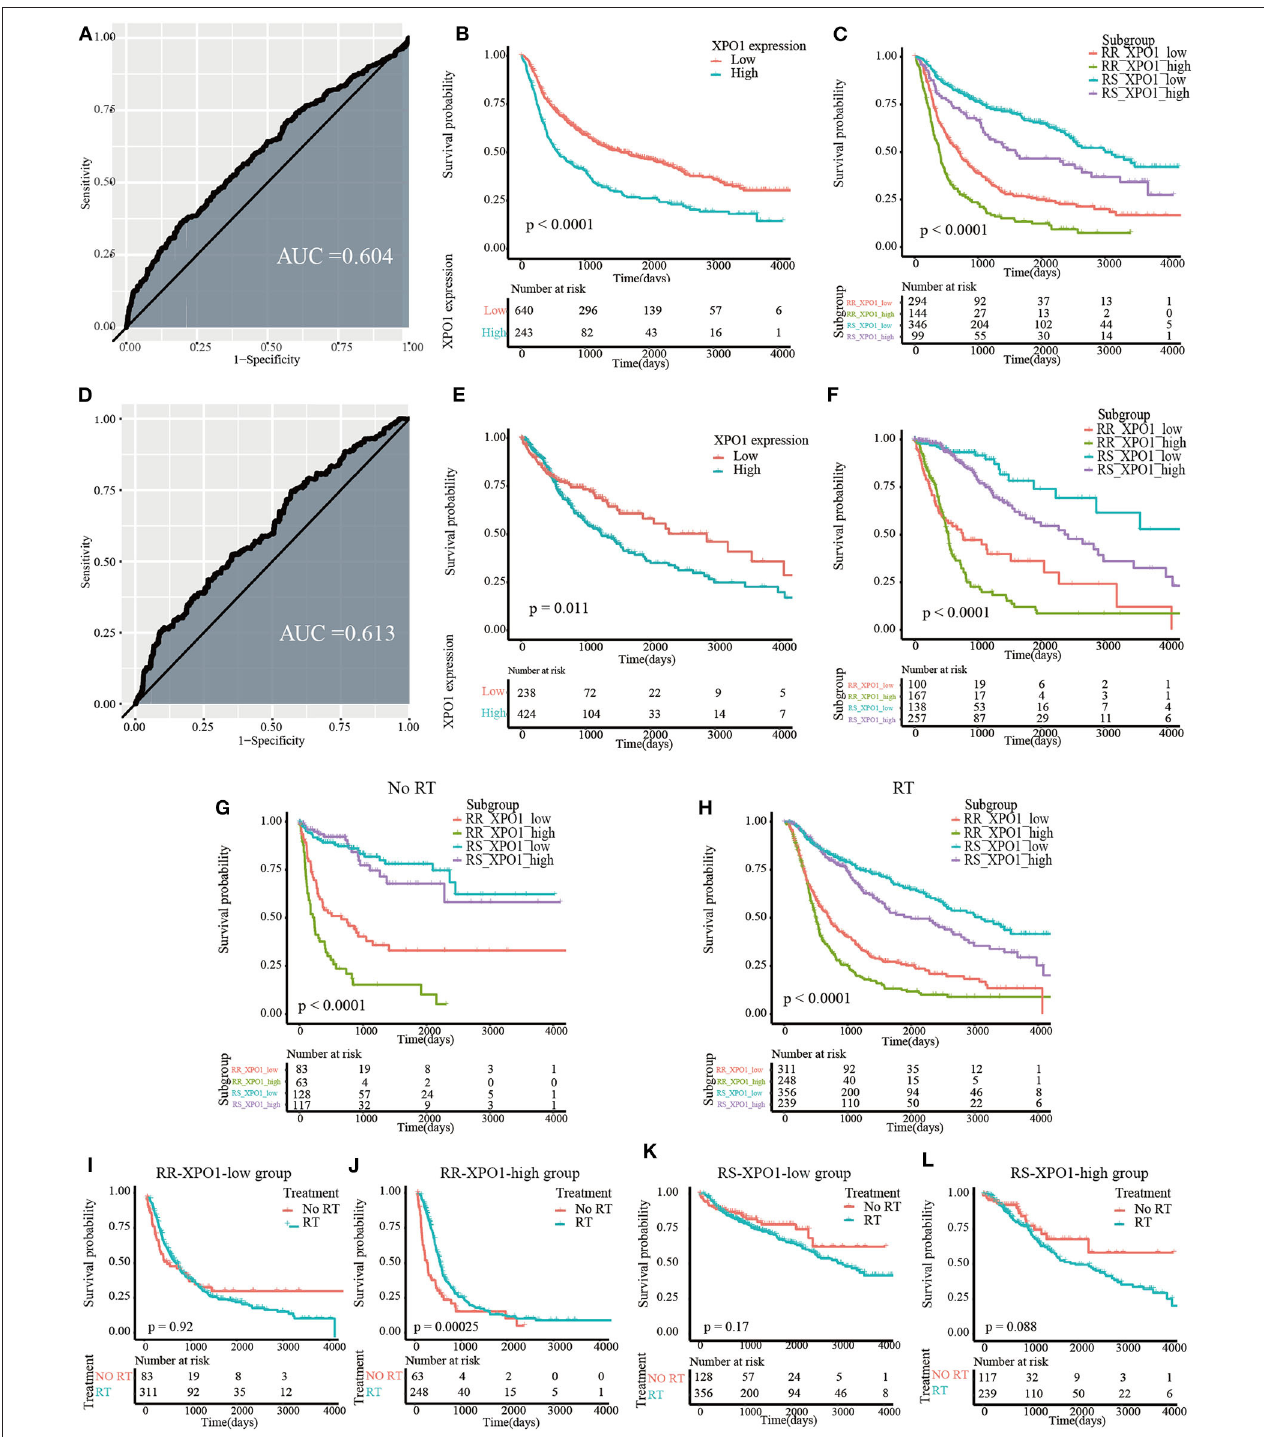
FIGURE 3 | Prognostic significance of XPO1 expression and 31-GS in different subgroups. (A,D) Definition of XPO1-high and XPO1-low groups by the ROC curve in the CGGA and TCGA cohorts. (B,E) Prognostic significance of XPO1 expression in the CGGA and TCGA cohorts. (C,F) Prognostic differences of subgroups stratified by combining XPO1 expression and 31-GS in the CGGA and TCGA cohorts. (G,H) Prognostic significance of subgroups stratified by combining XPO1 expression and 31-GS for patients with and without RT. (I–L) Comparison of OS rates stratified by RT in the four subgroups stratified by combining XPO1 expression and 31-GS.